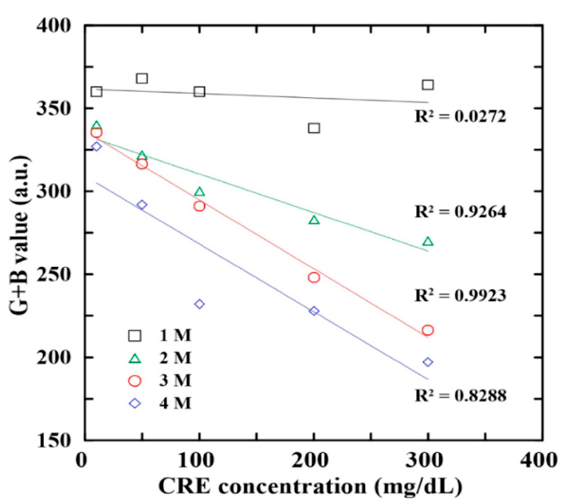
Figure 3. Effects of NaOH concentration on G + B intensity value of reaction complexes with different CRE contents. CRE